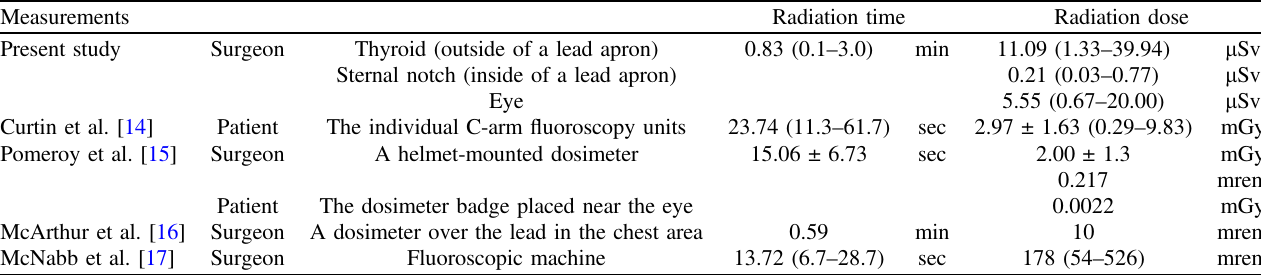
Table 3. The comparison with previous studies on exposure time.